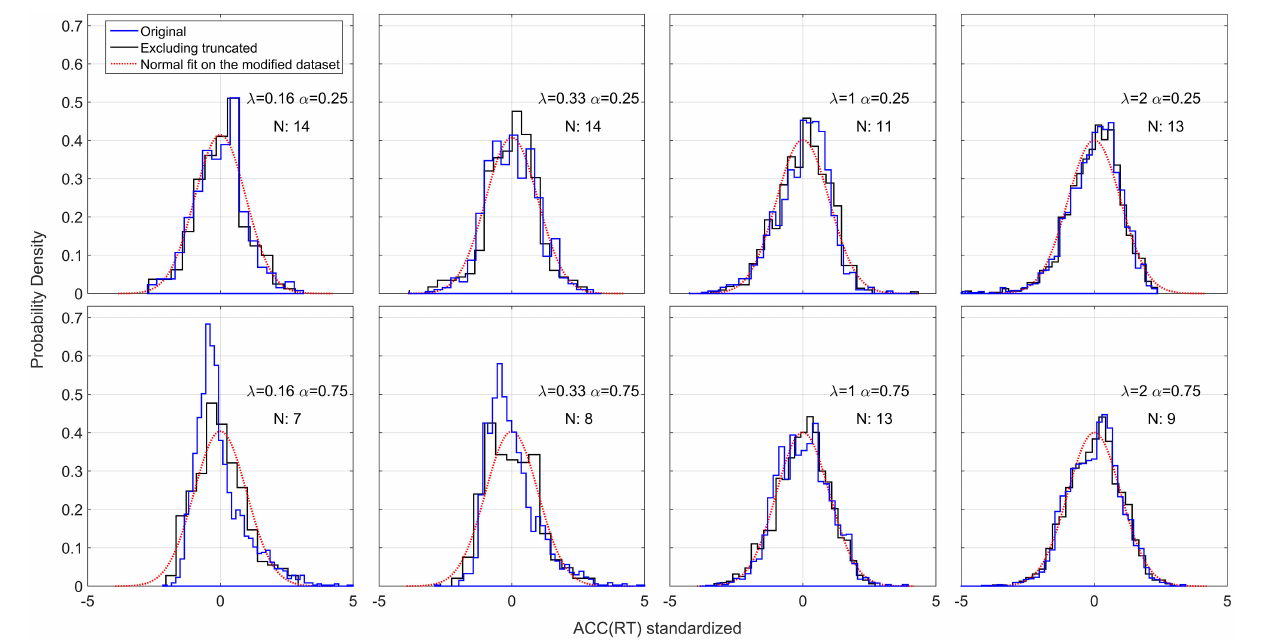
FIGURE 10 | Standardized positional response along the gauge: ACC ( RT ) . The blue lines represent the original standardized and collapsed distributions; the black lines represent the standardized and collapsed distributions after eliminating the datasets with severe truncation. N represents the number of remaining datasets (out of a total of 20 participants) after eliminating severely truncated distributions. A normal density is fitted to each modified distribution.